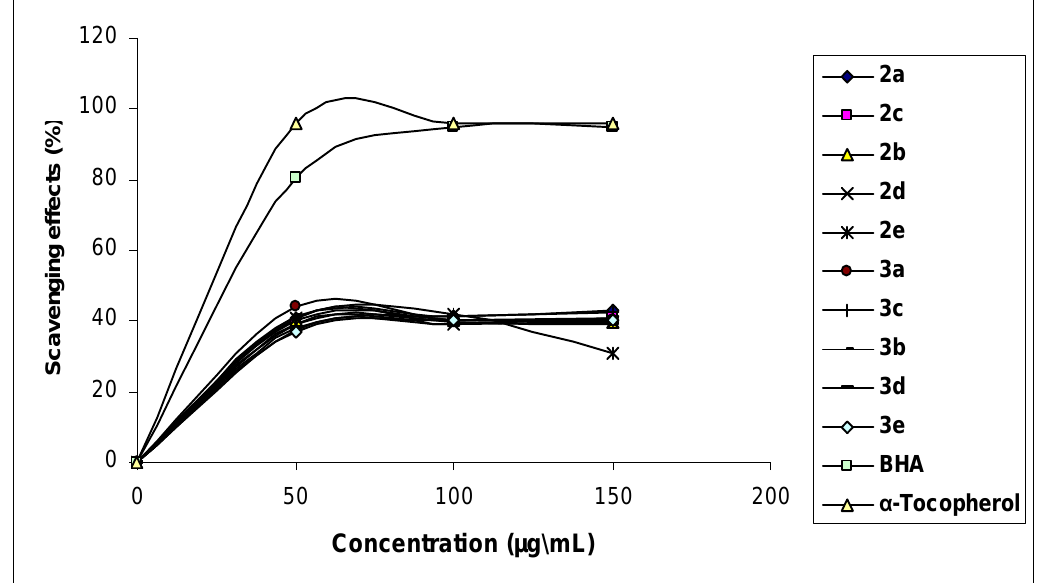
Figure 3. Scavenging effect of compounds 2 , 3 , BHA and α -tocopherol at different concentrations (50-100-150